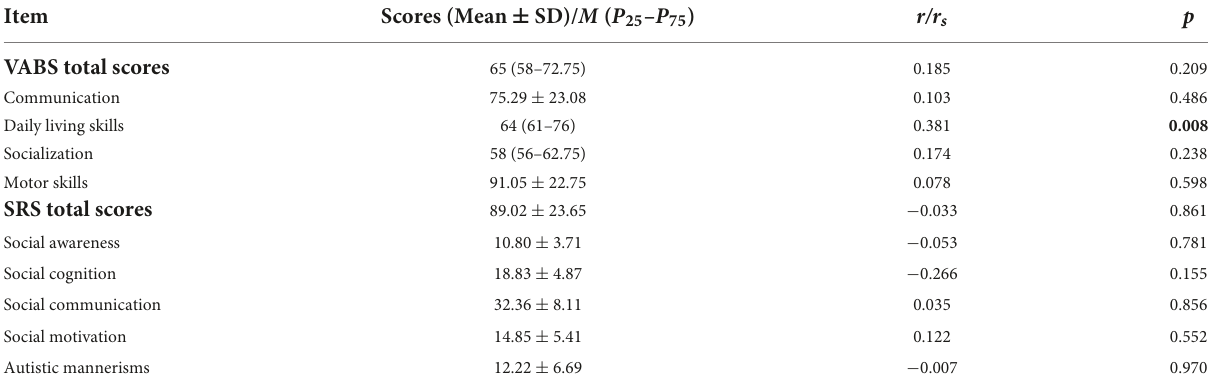
TABLE 2 Relationship between the ST8SIA2 level and the adaptive behavior and social behavior in children with autism spectrum disorder